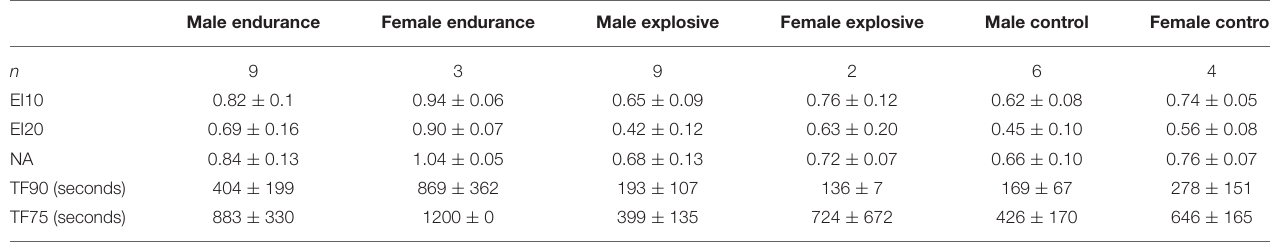
TABLE 2 | Mean ( ± SD) values of endurance indices (EI), normalized force area (NA), and time to fatigue (TF) metrics for sport. Male endurance Female